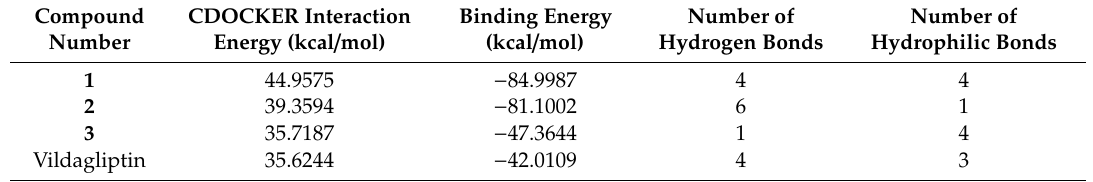
Table 3. CDOCKER results and docking mode analysis results for compounds 1 – 3 and vildagliptin.